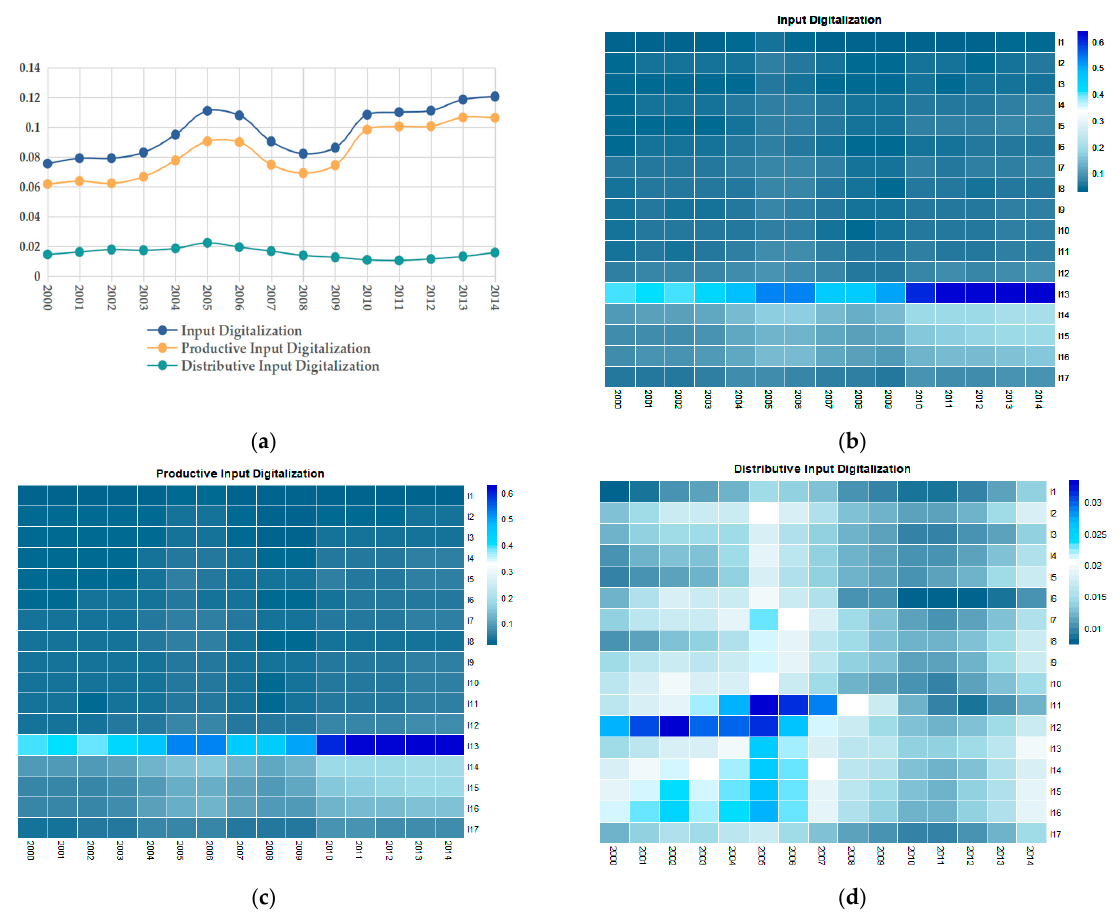
Figure 2. ( a ) Average input digitalization of 17 manufacturing industries from 2000 to 2014; ( b ) Development of input digitalization in 17 manufacturing industries from 2000 to 2014; ( c ) Development of productive input digitalization in 17 manufacturing industries from 2000 to 2014; ( d ) Development of distributive input digitalization in 17 manufacturing industries from 2000 to 2014.